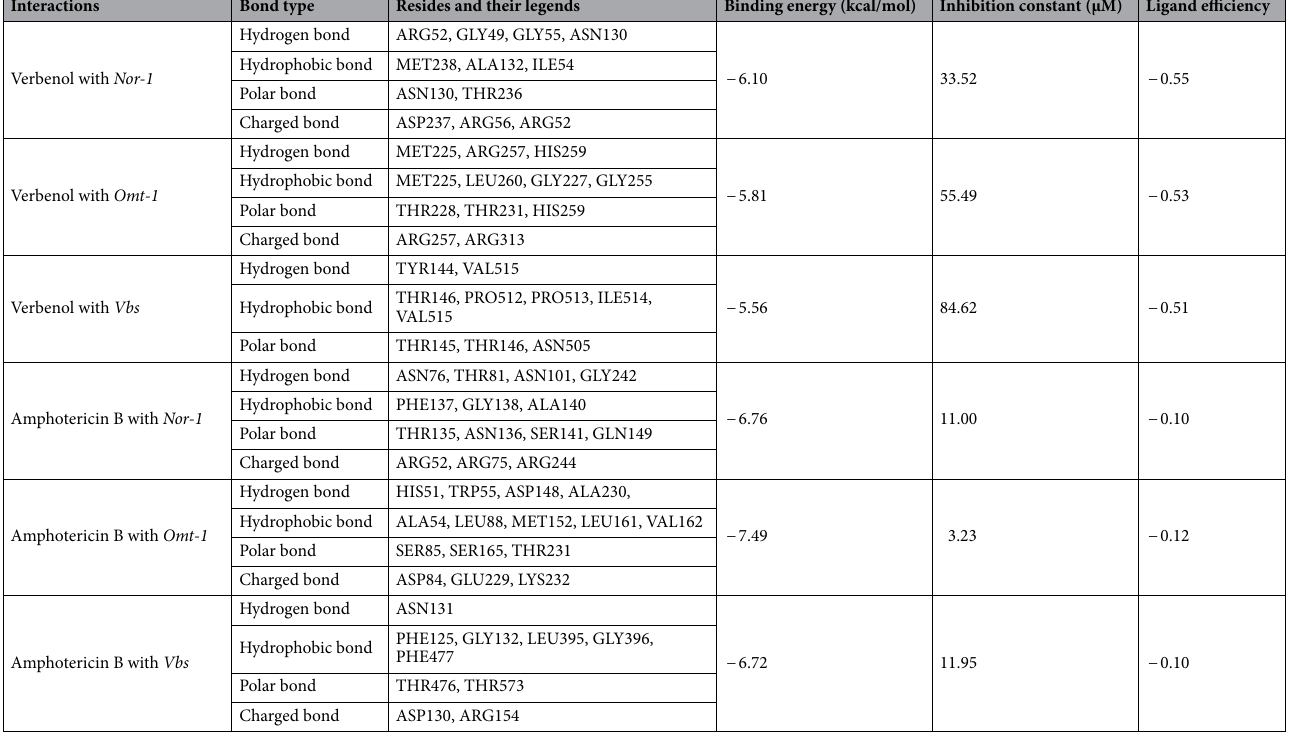
Table 3. Docking details of all the three protein–ligand